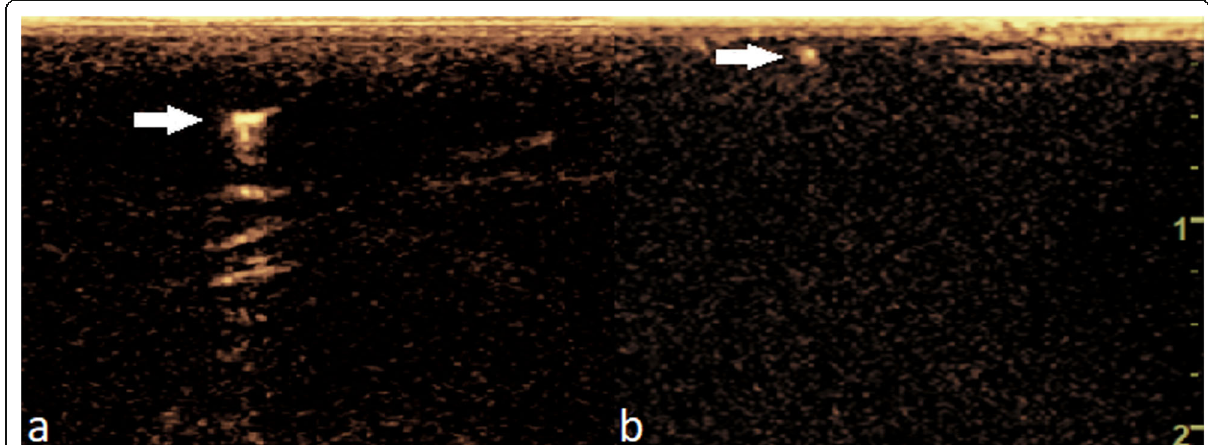
Fig. 3 The CEUS image in a correlates with a type A (strong enhancement) in the superficial lymphatic vessel, whereas the CEUS image in b corresponds to type B (moderate enhancement), which is clearly seen from the background but is clearly more faint than type A. White arrows mark the enhancing superficial lymphatic